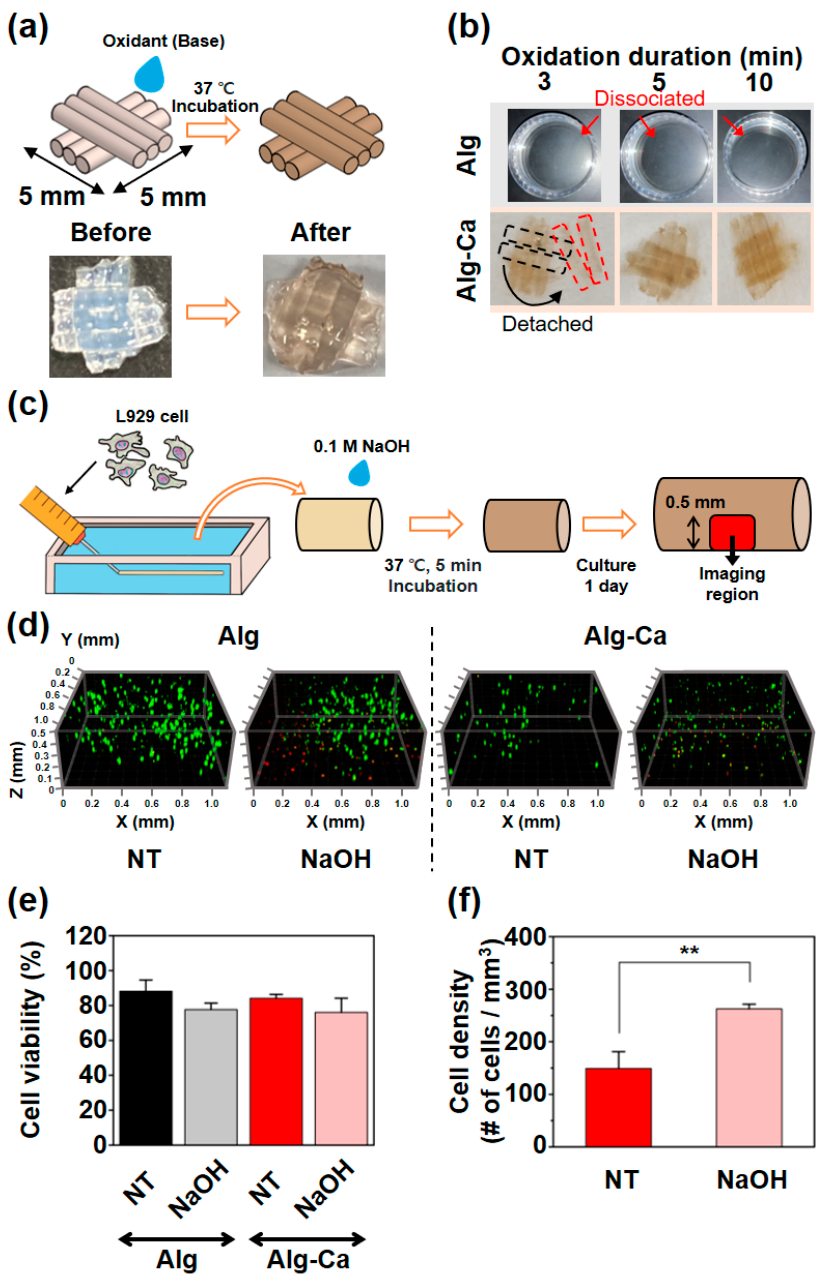
Figure 5. Constructing fiber-based 3D structure and fabricating cell loaded Alg-Ca fibers. ( a ) Schematic illustration of 3D structure and oxidant treatment (top), and images of 3D structure before (left bottom) and after (right bottom) treatment. ( b ) Images of 3D structure based on Alg (top) and Alg-Ca (bottom) fibers depending on oxidation duration after 24 h swelling in PBS. Alg fibers were dissociated (red arrow) and nothing remained in PBS. Black dashed line indicates original position of detached fiber (red dashed line). ( c ) Schematic illustration of procedure for fabricating cell loaded fibers and confocal imaged region (red square, depth = 0.5 mm). Result of live/dead cell staining, 3D view of Alg (left) and Alg-Ca (right) fibers ( d ), cell viability ( e ), and cell density ( f ). ( d ) Green for live cells and red for dead cells. Z = 0 is edge of fibers. ( e ) Cell viability of after a day culture in Alg fiber NT group (first bar), NaOH treated group (second bar) and Alg-Ca fiber NT group (third bar), NaOH treated group (fourth bar) ( n = 3, mean ± SD). ( f ) Cell density of after a day culture in Alg-Ca fiber NT group (first bar) and NaOH treated group (second bar) ( n = 3, mean ± SD) (** p <